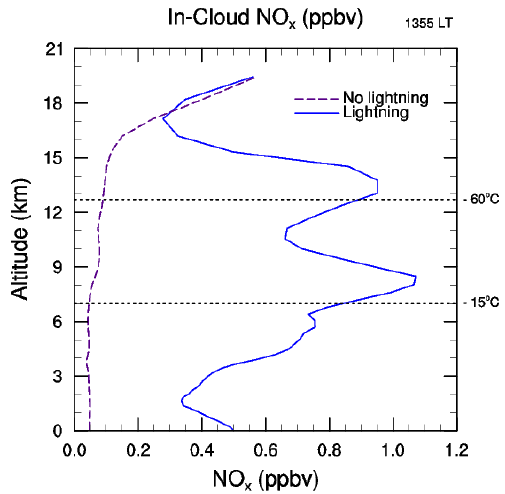
Fig. 17. Average in-cloud NO x at 13:55LT for model simulations with and without lightning. Above 17.1km, values represent the average NO x directly above the cloud at 17.1km for model sim- ulations with and without lightning. The dashed lines at 7.0 and 12.7km represent the usual altitude of the isotherms used for the lower and upper modes, respectively, of the vertical distribution of the lightning NO x